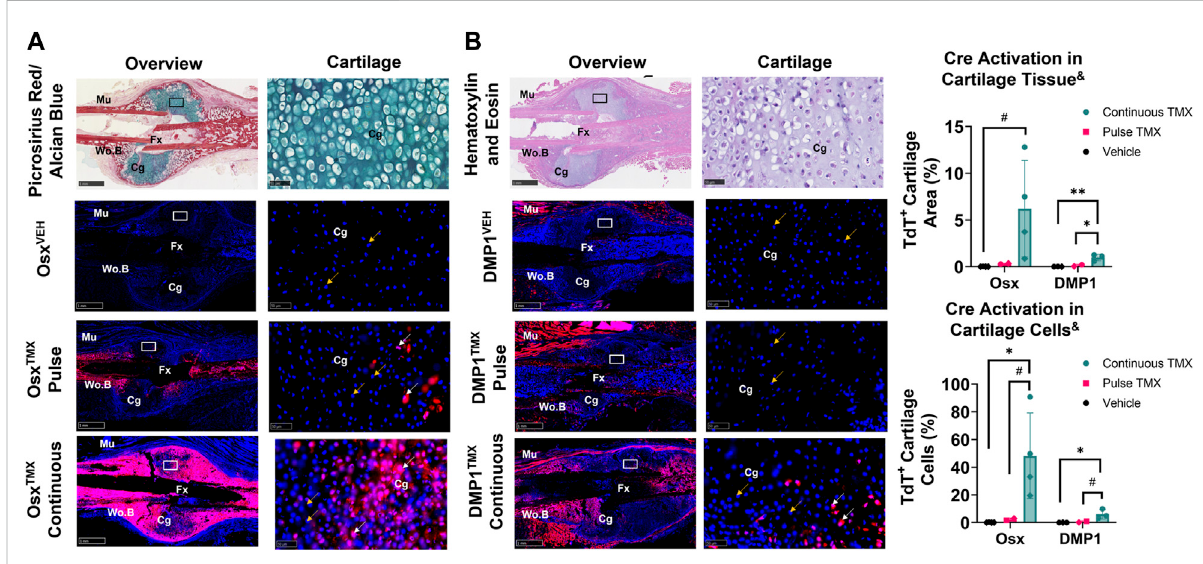
FIGURE 5 Newly-derived but not pre-existing Osx + (panel (A) ) and DMP1 + (panel (B) ) lineage cells and their progeny make up cartilage callus following femoral fracture (endochondral region). 2.5X (Overview; scale bar 1 mm) and 40X images (cartilage - scale bar 50 μ m; black/white ROI boxes) were randomly taken and averaged from two regions of interest centered in cartilage regions adjacent to the PID14 fracture site (Fx). TdTomato positive callus area were calculated from automated thresholding for TdT + area within each fi eld of view. Cartilage TdTomato positive cells (TdT + Cg cells - white arrow) were thresholded, counted and normalized to total number of DAPI + chondrocytes (TdT + and TdT − cells - orange arrow). Data presented asmean± SDwith n =2 – 4pergroup. Mousesexofeachdata pointisrepresentedbyshape(circle – female;diamond – male). & Signi fi